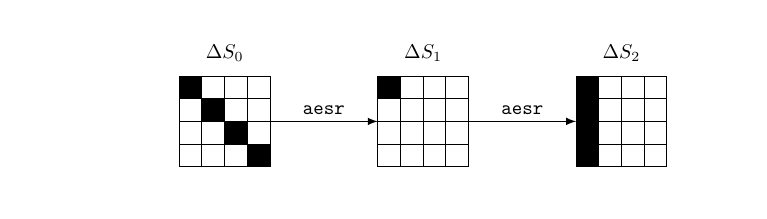
Figure 4: Differential path.